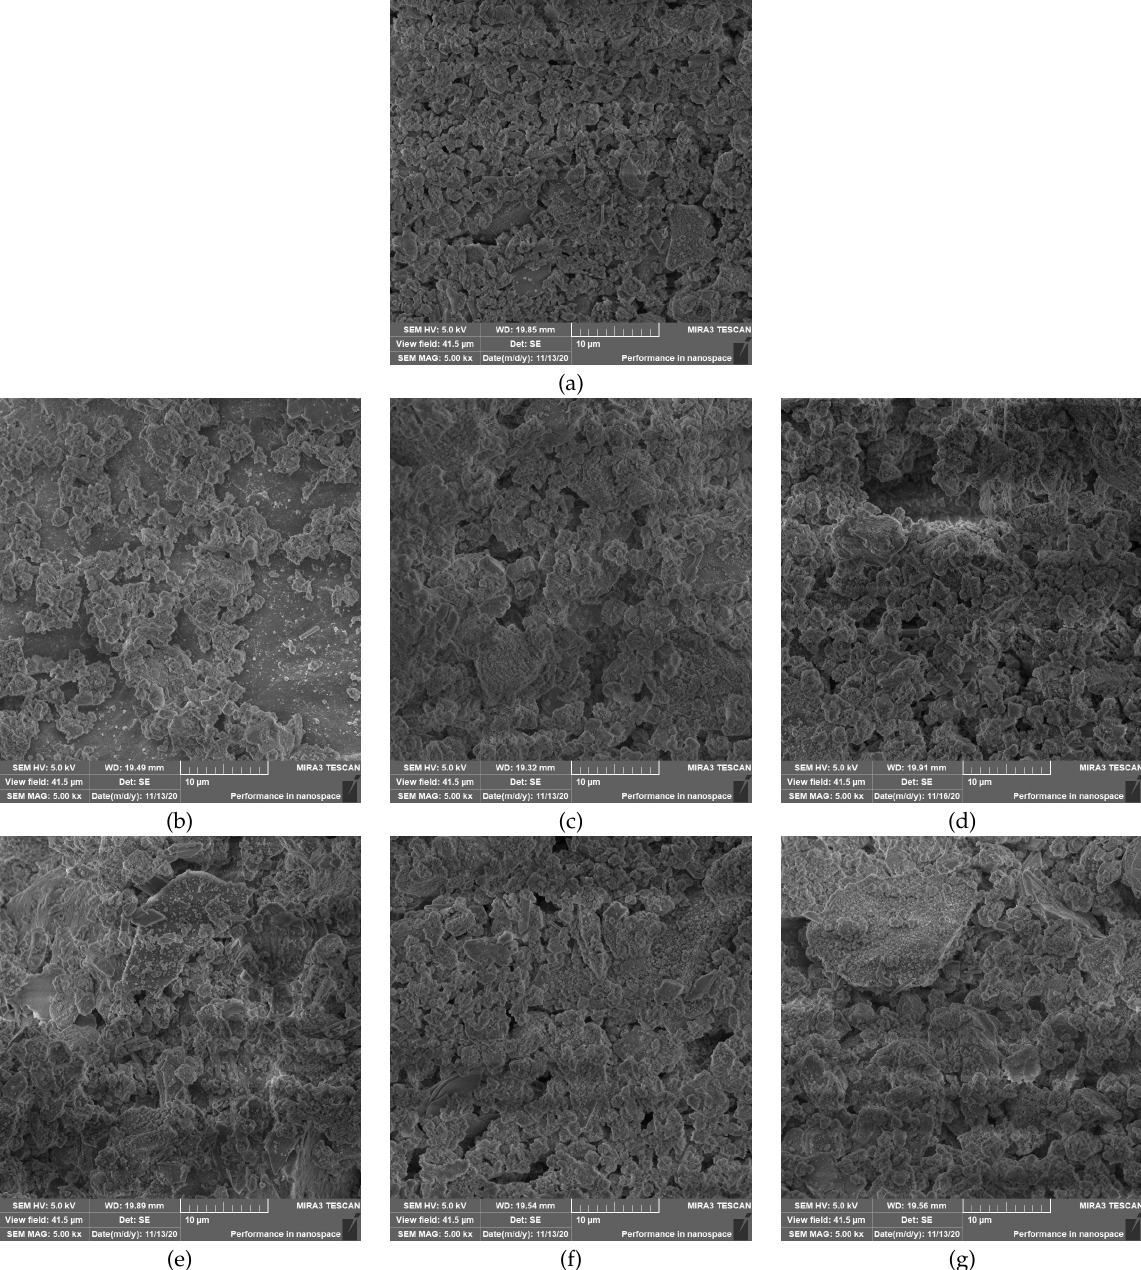
Fig. 6. Microstructure of mortars at 5000 times of magnifying power. (a) standard mortar; (b) HDPEM2.5; (c) HDPEM5; (d) HDPEM10; (e) PSM2.5; (f) PSM5; (g)